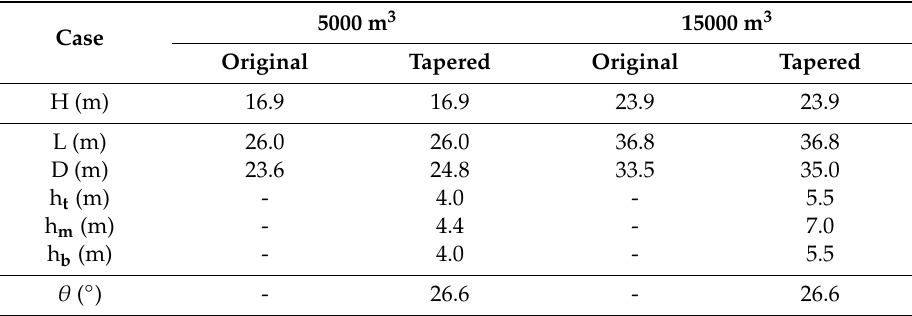
Table 4. Tank Table 4. Tank dimensions.